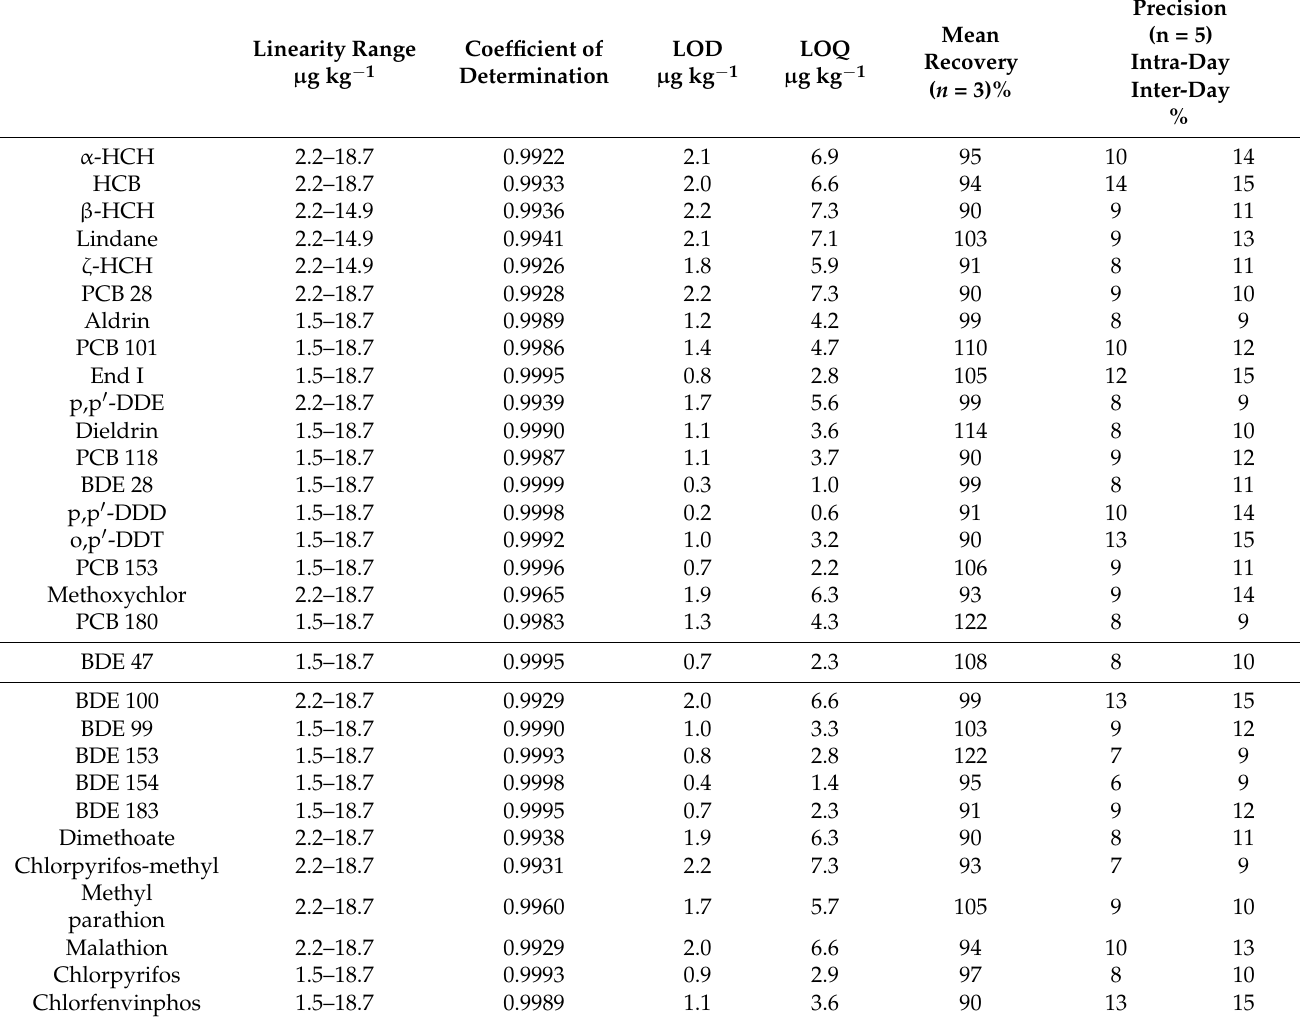
Table 1. Data including correlation to the matrix-matched calibration curve, the limit of detection (LOD) and limit of quantification (LOQ), mean recoveries (from three spiking levels), and precision obtained for the 30 target